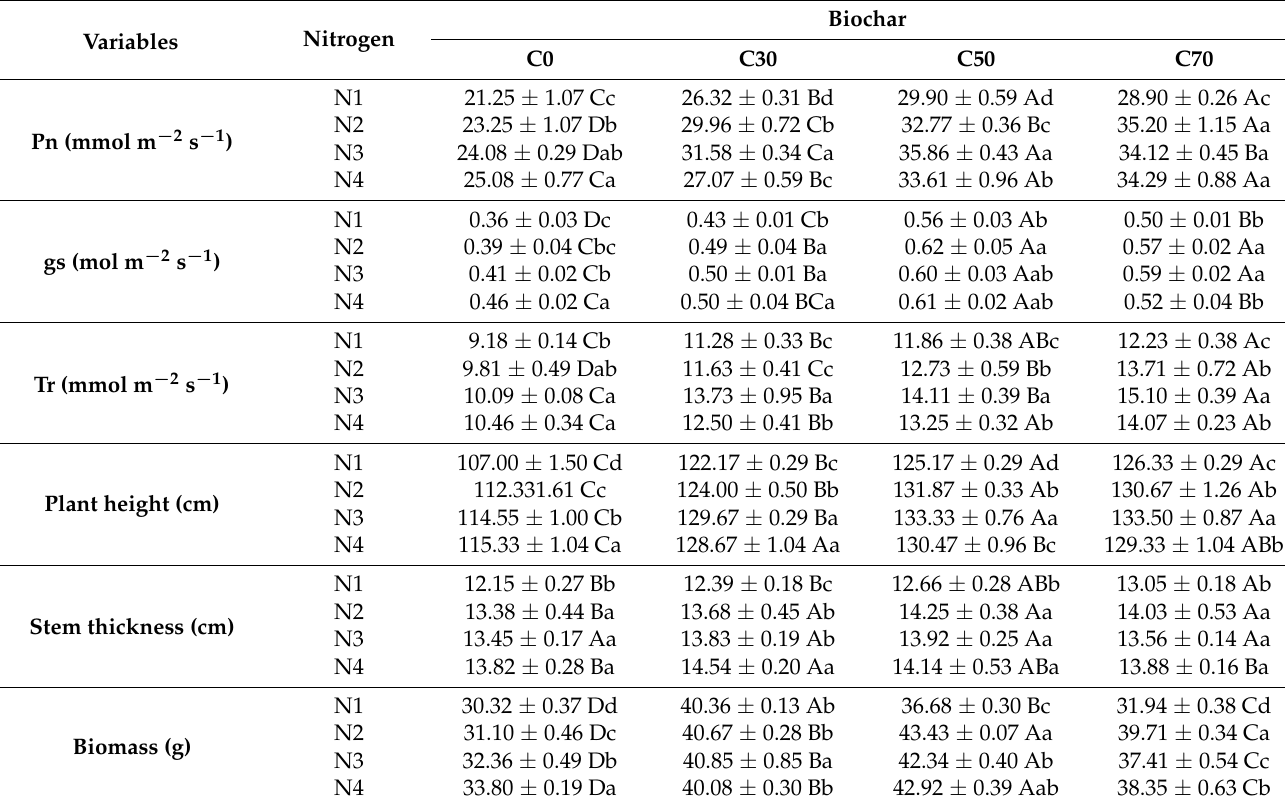
Table 4. Descriptive statistics of leaf gas exchange parameters, tomato growth, and biomass as affected by N (N1, N2, N3, N4) and biochar (C0, C30, C50, C70); each value is the mean value of three replicates ± standard